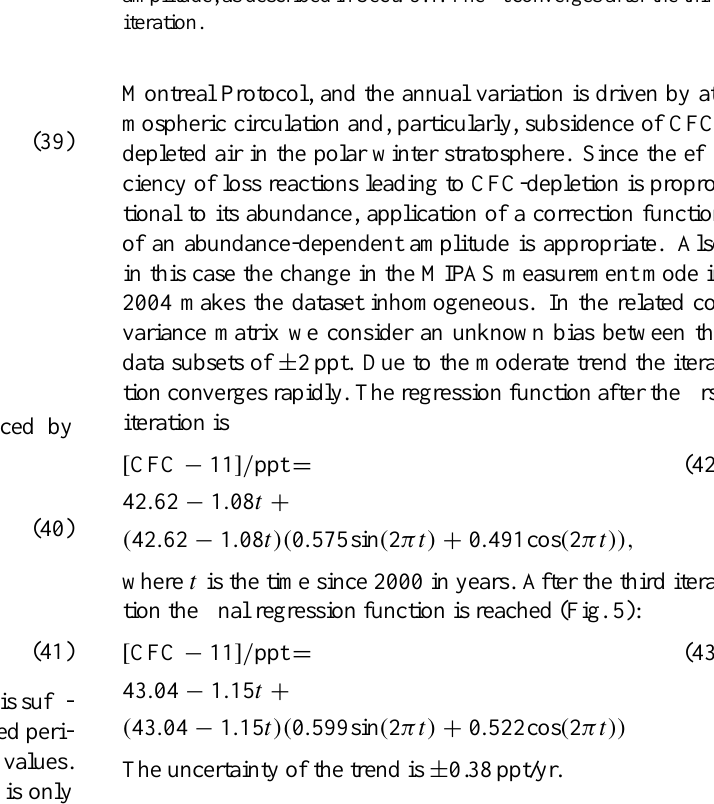
Fig. 5. Linear trends from MIPAS monthly mean CFC-11 at 20km altitude, 60 ◦ S–90 ◦ S, using periodical correction of state-dependent amplitude, as described in Sect. 3.4. The fit converges after the third